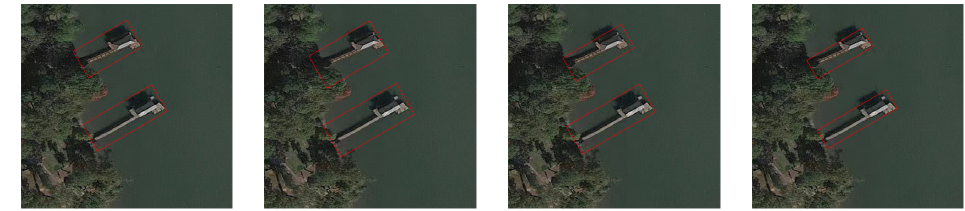
Figure 13. Qualitative results for Bounding Box.